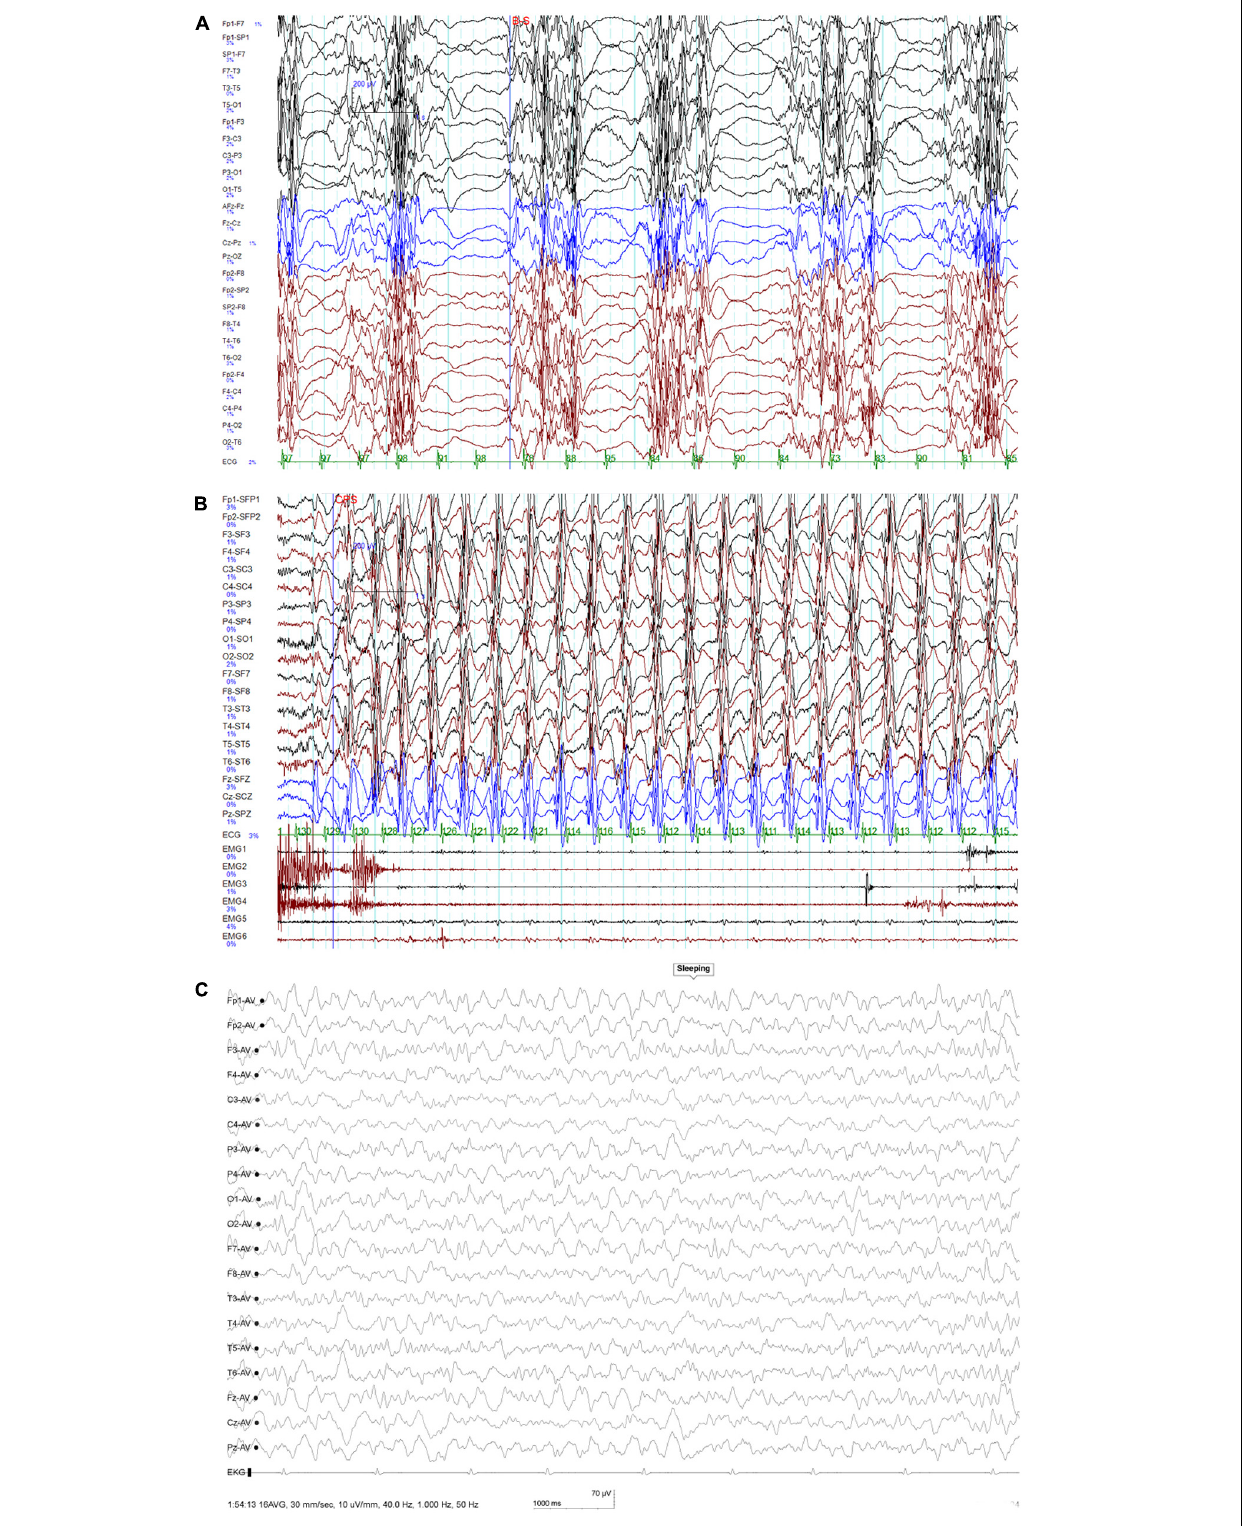
FIGURE 1 | (A) Interictal EEG at 6 years of age showing periodic occurrence of diffuse paroxysmal multiple spike-and-slow-wave complexes and usually a second or so of suppression seen thereafter. (B) Ictal EEG at 6 years of age indicating slow waves of high amplitude at 2–3 Hz with spike-and-wave complexes. (C) At 6.5 years of age, this EEG was taken when the seizure was controlled: no ictal episode was noted during monitoring.